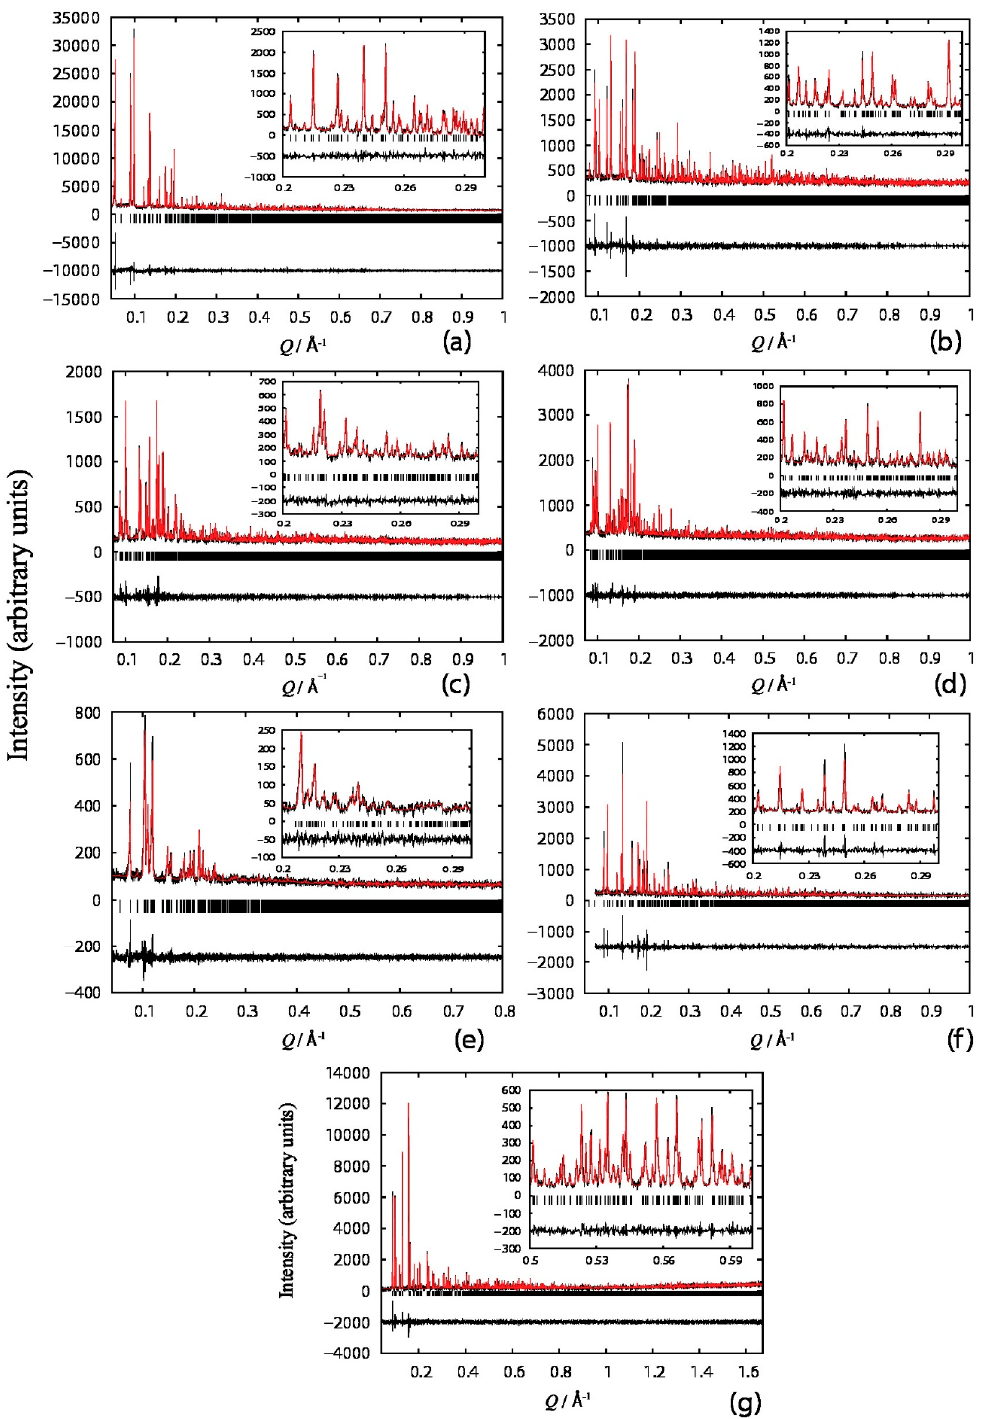
Figure 13. LeBail fits of seven Uox phases collected on ID31-ESRF [295 K, λ = 1.30000 (6) Å]. ( a ) Ligand-free Uox crystallized with NH 4 Cl and 15% PEG 8000 ( P 3 1 21), ( b ) ligand-free Uox crystallized in water with 10% PEG 8000 ( P 2 1 2 1 2), ( c ) ligand-free Uox crystallized with NaCl and 15% PEG 8000 ( P 2 1 ), ( d ) ligand-free Uox crystallized with (NH 4 ) 2 SO 4 and 15% PEG 8000 ( P 2 1 ), study. ( e ) Ligand-free Uox crystallized with NaCl and 8% PEG 8000 ( P 2 1 ), ( f ) ligand-free Uox crystallized with KCl and 10% PEG 8000 ( P 3 1 21), ( g ) Uox complexed with AZA and crystallized with NaCl ( I 222). The black, red and lower black lines represent the experimental data, the calculated pattern and the di ff erence between the experimental and calculated profiles, respectively (Q = 4 π · sin θ · λ − 1 ). The vertical bars correspond to Bragg reflections compatible with the particular space group